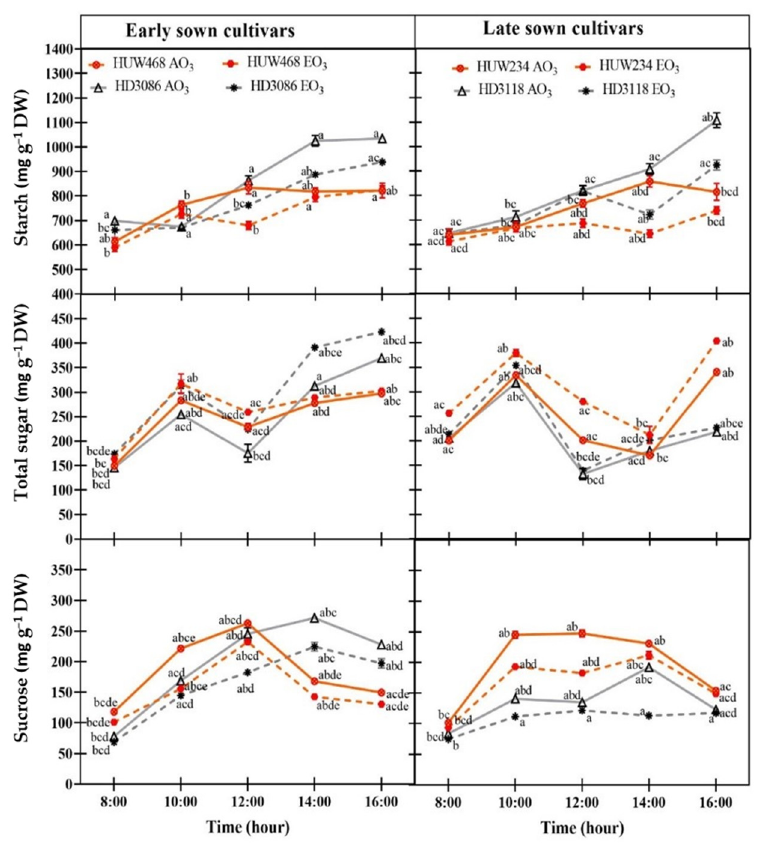
Figure 4. Diurnal variations in starch, total sugar, and sucrose contents of flag leaf in early (HUW468 and HD3118) and late sown (HUW234 and HD3118) wheat cultivars under ambient and elevated O 3 treatments. The letters on top of the line graph are based on the Tukey test among the five different time intervals of a day. Lines without the same letter are significantly different from each other at p < 0.05. Values are mean ± SE; N = 5 replicate leaves of 5 plants for each treatment. Solid lines represent plant response under ambient O 3 condition and dotted lines indicate plant response under elevated O 3 condition. Different color in a box represents different cultivar.